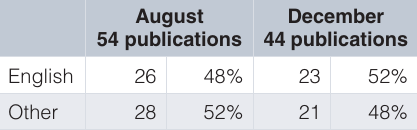
Table 6c. Language of publications without UID not exported from Pure to SciVal. Download from August and December 2015.